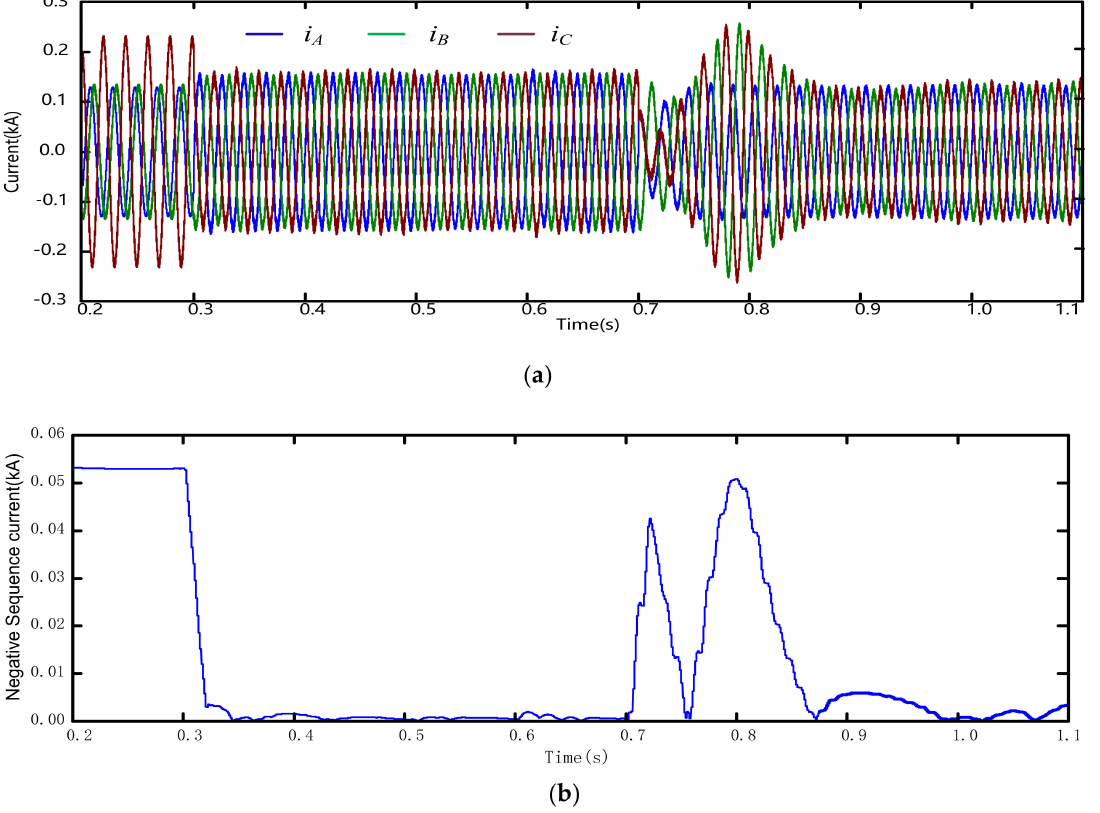
Figure 10. Three-phase current and negative sequence current of PPS in PQC mode and UPSP priority, PQC optimum mode: ( a ) Three phase current from PPS; ( b ) Negative sequence current into